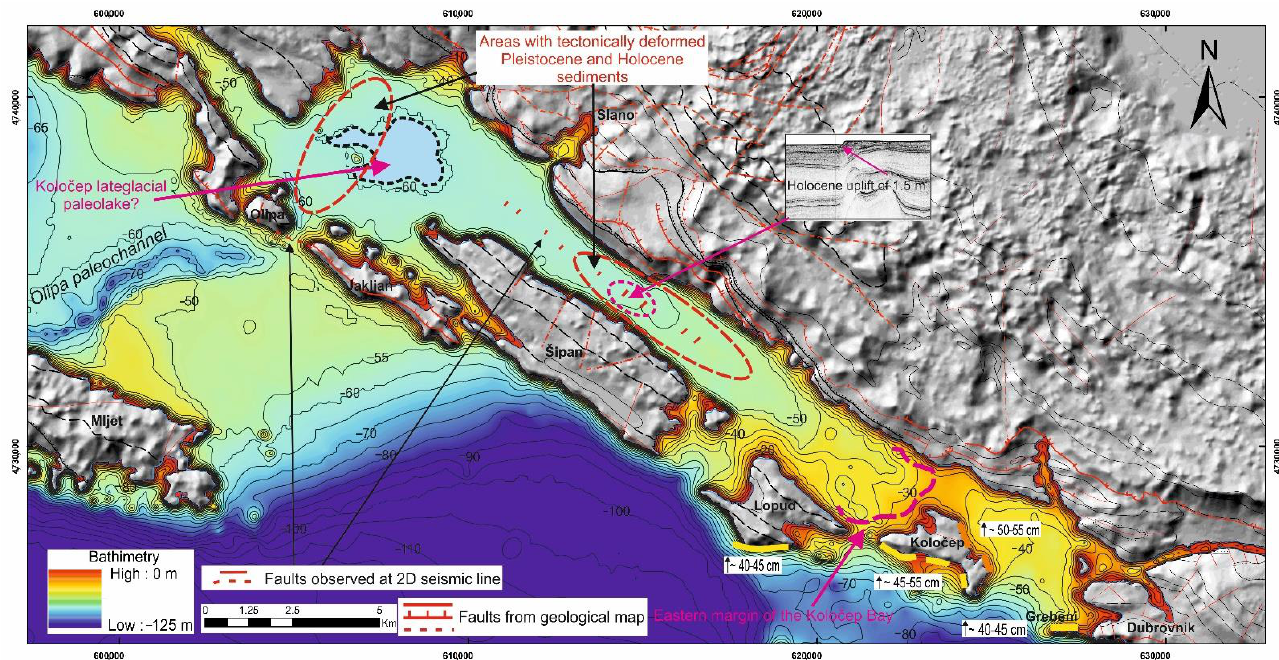
Figure 19. Bathymetric map over DEM with main faults in the area. The area marked with a red – dashed circle shows tectonically deformed Pleistocene and Holocene sediments observed on 2D seismic profiles. Yellow (1667 AD seismic event) and orange (1520 AD seismic event) marks show uplifted segments of the coast of the islands Lopud (modified from [68]) and Koločep and Grebeni islets by major co-seismic events in the area, with estimated uplift (modified from [46]).